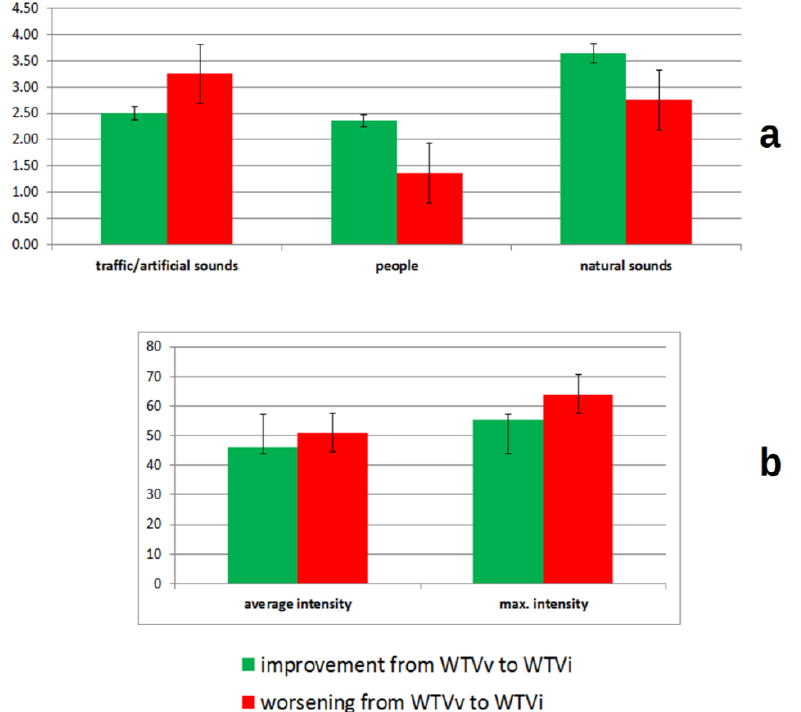
Figure 5. ( a ) Average sound perception (5-point Likert scale) for sound typology and Figure 5. ( a )Averagesoundperception(5-pointLikertscale)forsoundtypologyandimprovement / worsening improvement/worsening of sound. ( b ) Average and maximum sound intensity (dBA) for of sound. ( b ) Average and maximum sound intensity (dBA) for improvement / worsening of sound. Source: Own improvement/worsening of sound. Source: Own elaboration.